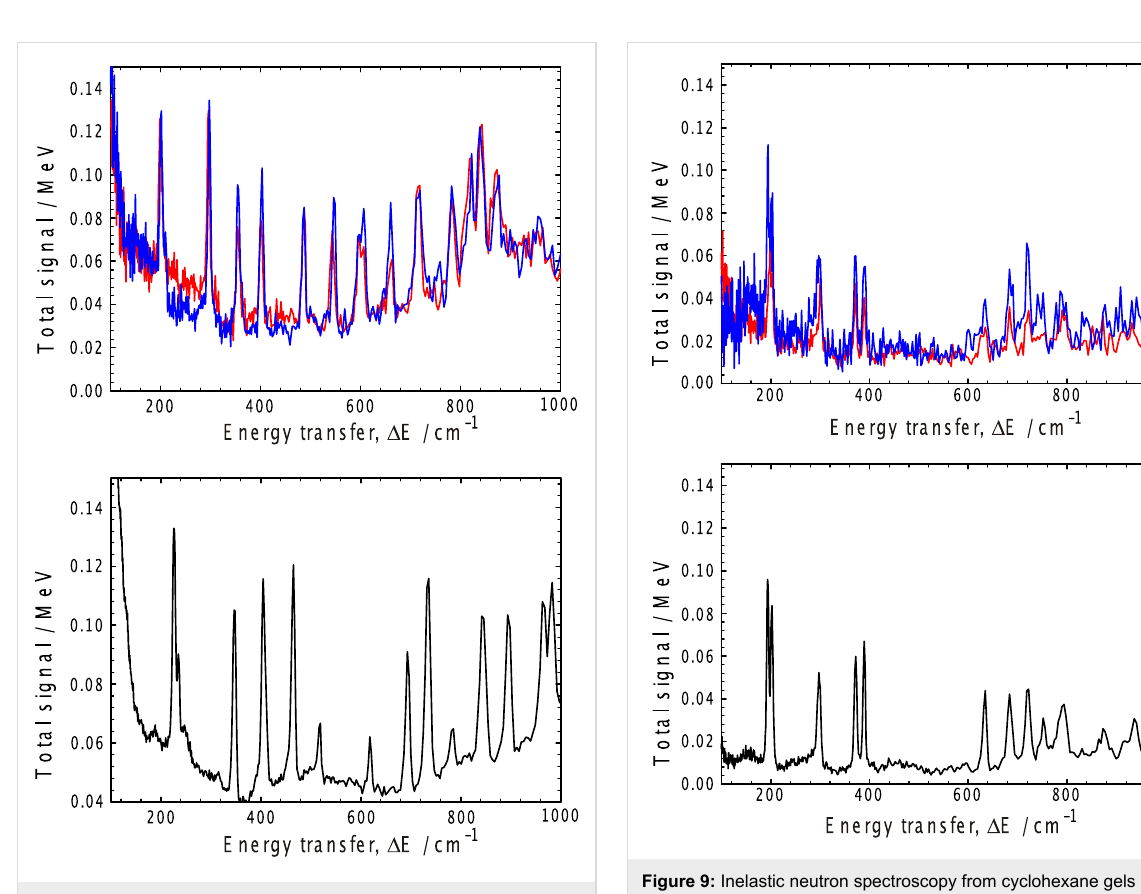
Figure 8: Inelastic neutron spectroscopy from toluene gels (upper Figure): red deuterated toluene/hydrogenous gelator, blue deuterated toluene/deuterated gelator, and the pure solvent (lower trace).